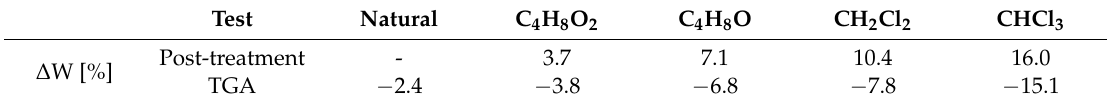
Table 3. Weight gain with post-treatment application and thermogravimetric analysis.